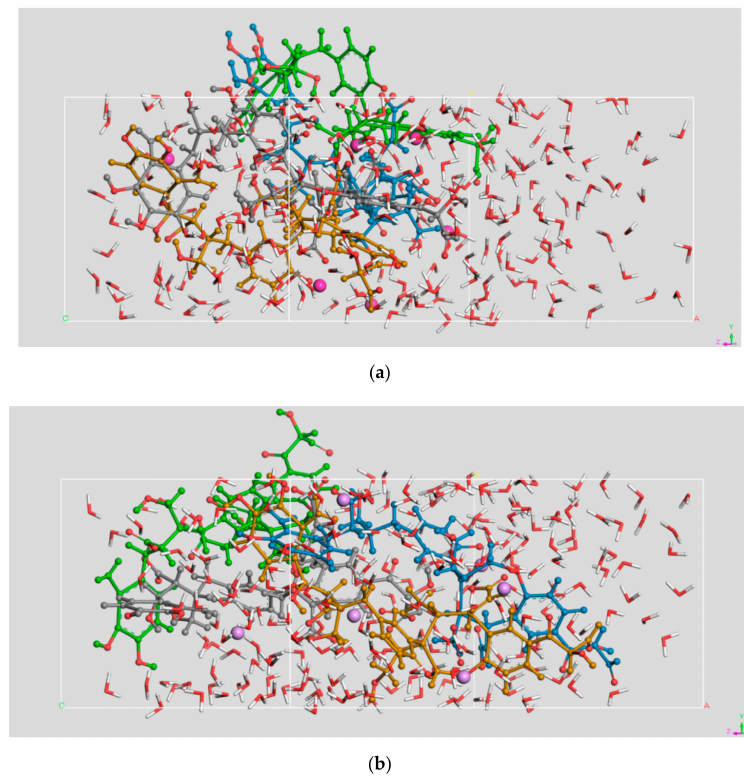
Figure 2. Snapshots of ( a ) Ca 2 + -TNB ( b ) Mg 2 + -TNB equilibrium after molecular dynamic simulation. Ca 2 + (pink), Mg 2 + (purple), O